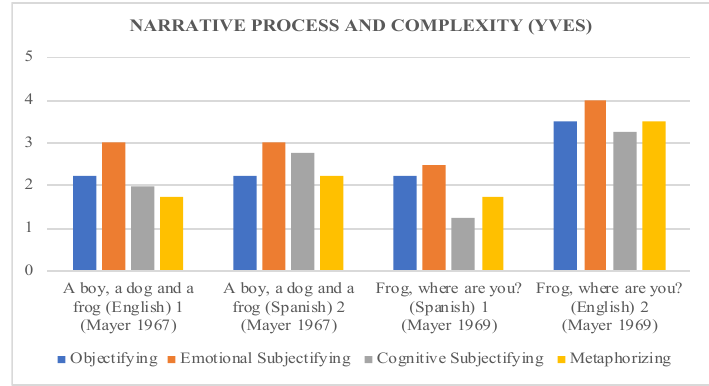
Figure 7. Yves’ scores for the narrative process and complexity dimension.